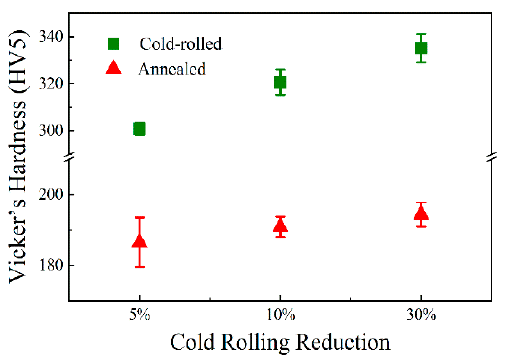
Figure 12. Vicker’s hardness of the AFA steel as a function of cold-rolling reduction for cold-rolled and cold-rolled annealed samples.